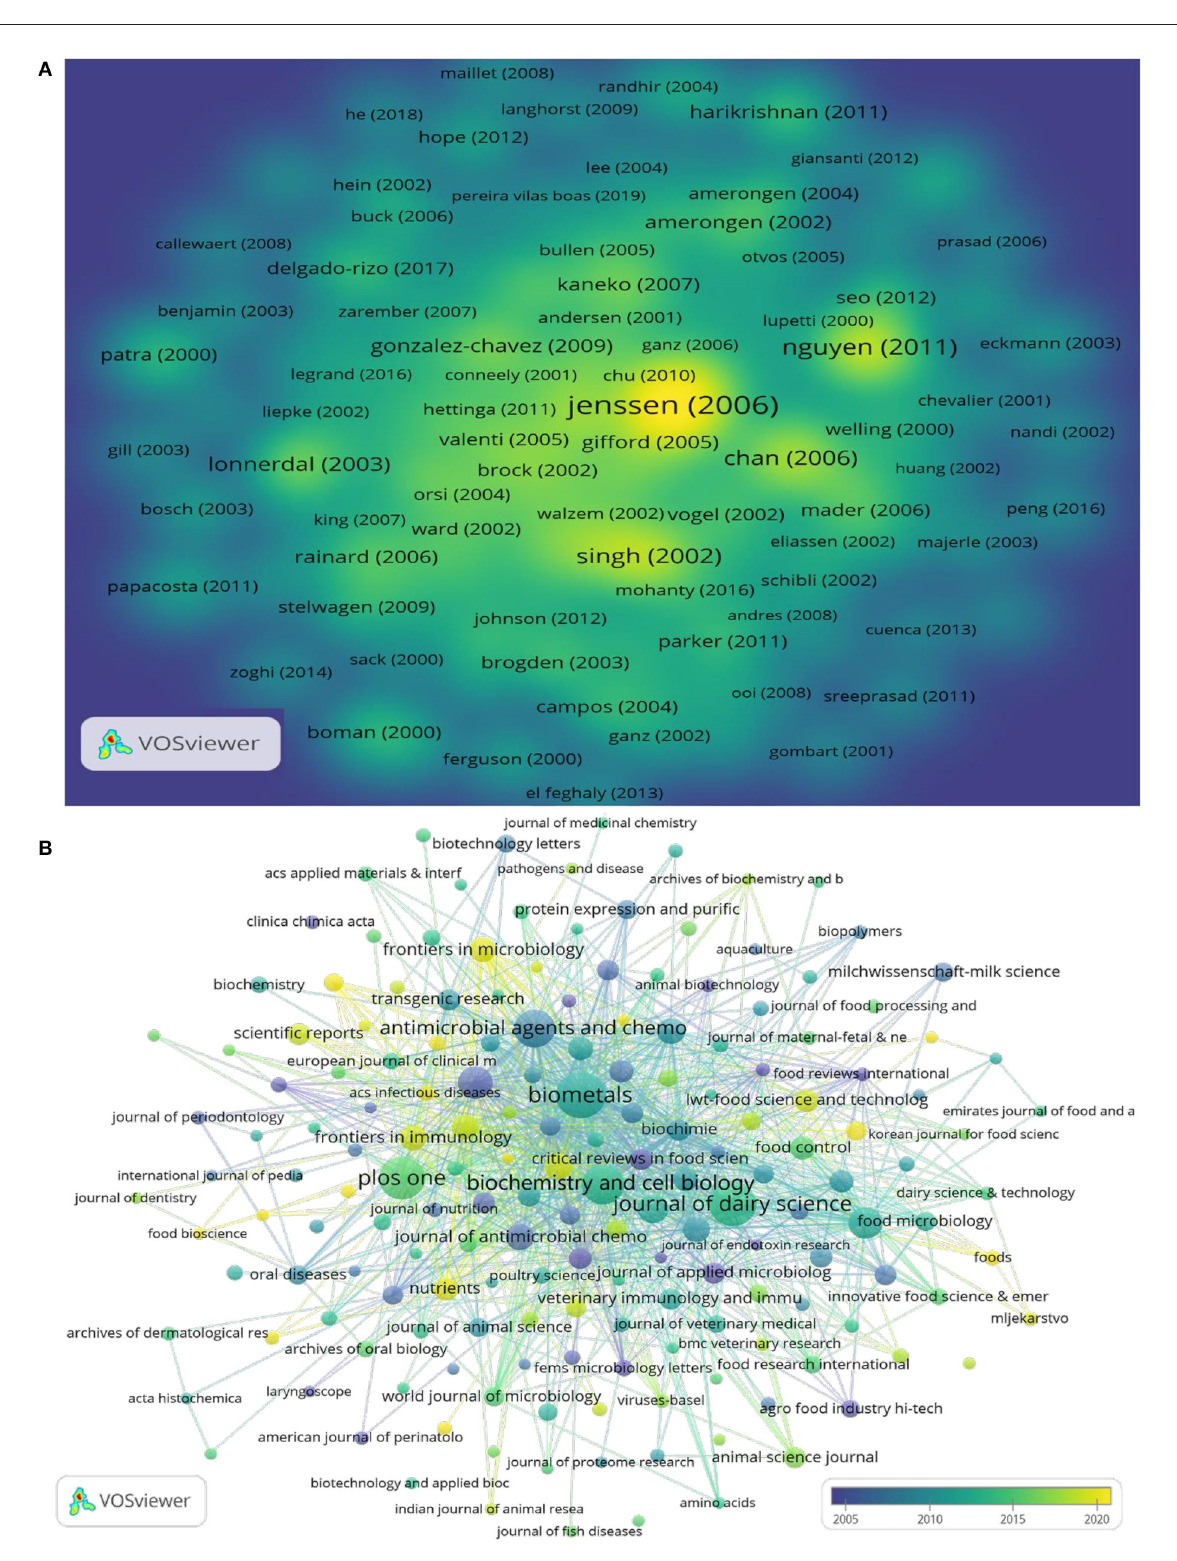
FIGURE7 (A) Density visualization for citations authors cluster network map. (B) Citations journals co-occurrence